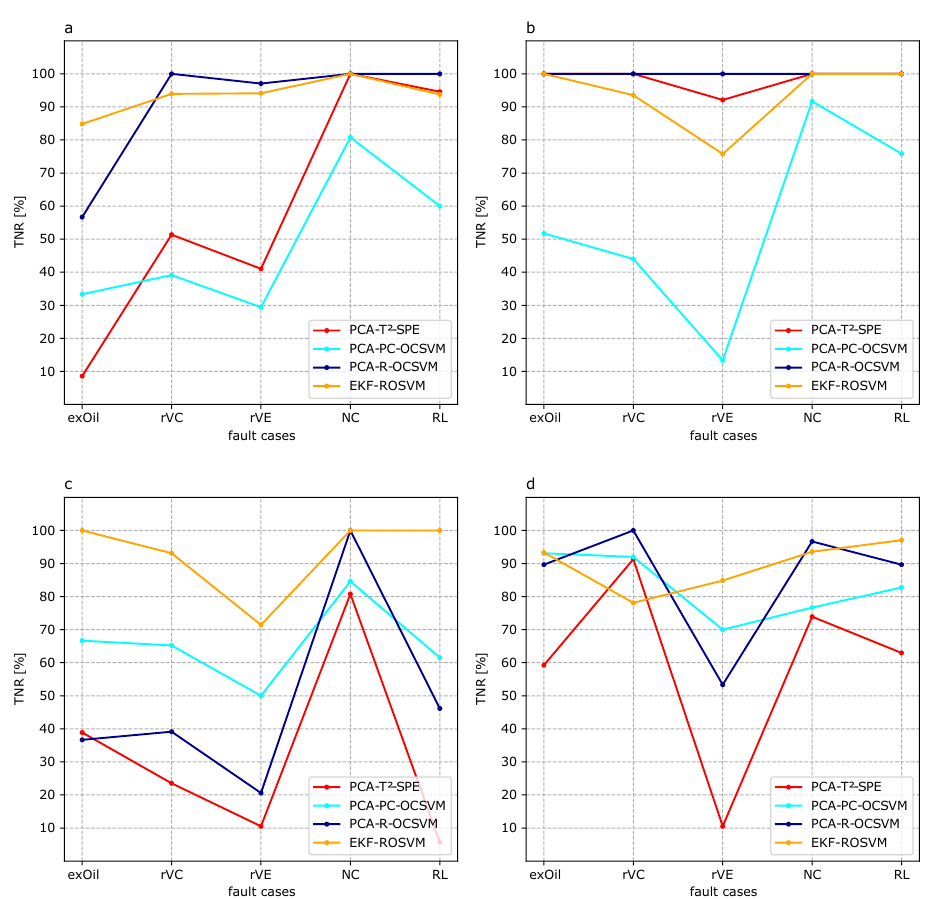
Figure 3. TNR of fault detection for DSs and SLs (a: DS1-SL1; b: DS1-SL4; c: DS2-SL1; d: